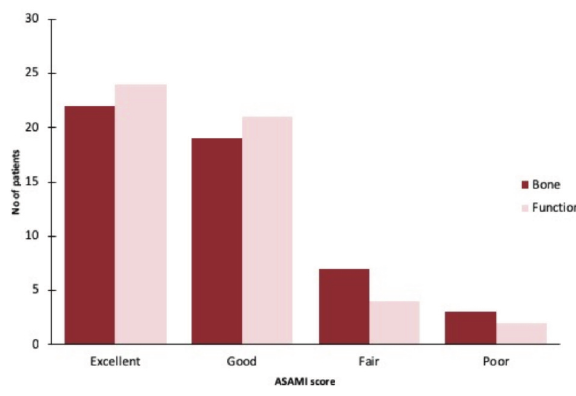
Comparison of outcomes as per ASAMI scoring Fig. 3: